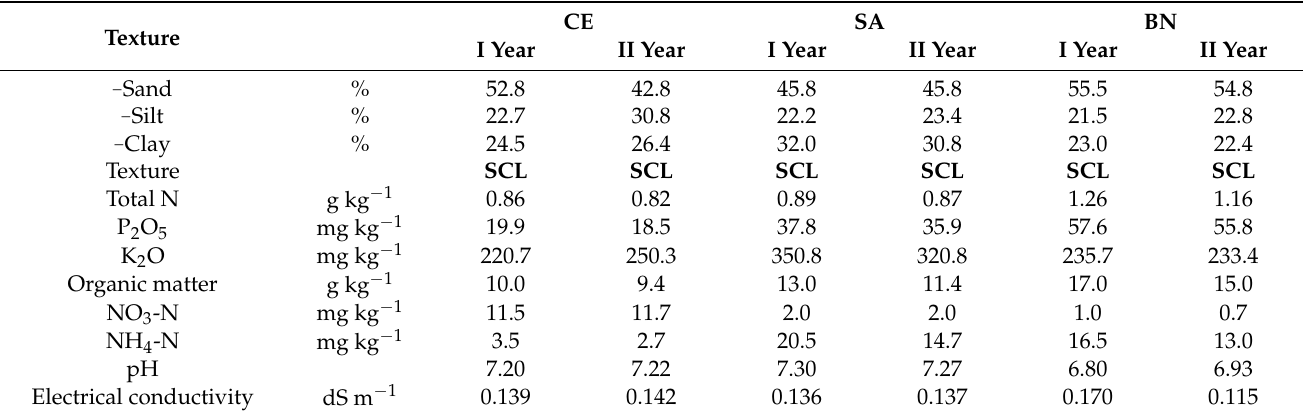
Table 1. Physical and chemical characteristics of soils at experimental fields (Vitulazio, CE; Bellizzi, SA; San Giorgio del Sannio,